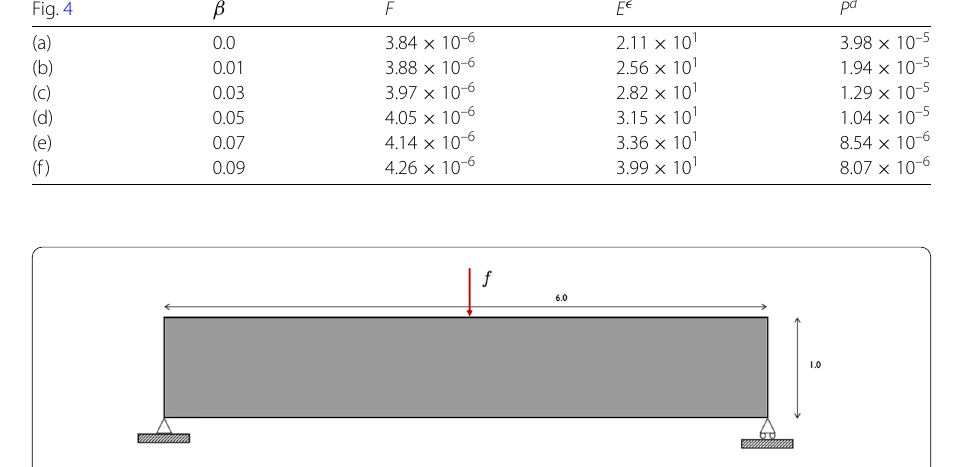
Table 1 Effect of the AMC for the Cantilever beam example Fig. 4